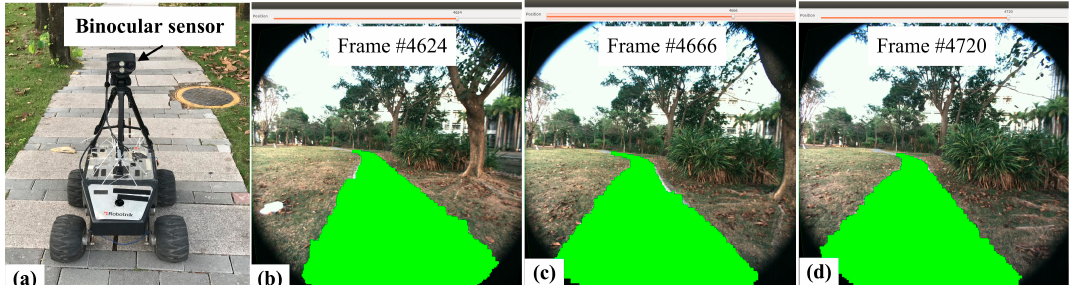
Figure 10. Real-time traversable region detection, ( a ) mobile robot platform with binocular sensor; ( b – d ) frame #4624, #4666, #4720 (image frame rate 30 fps).